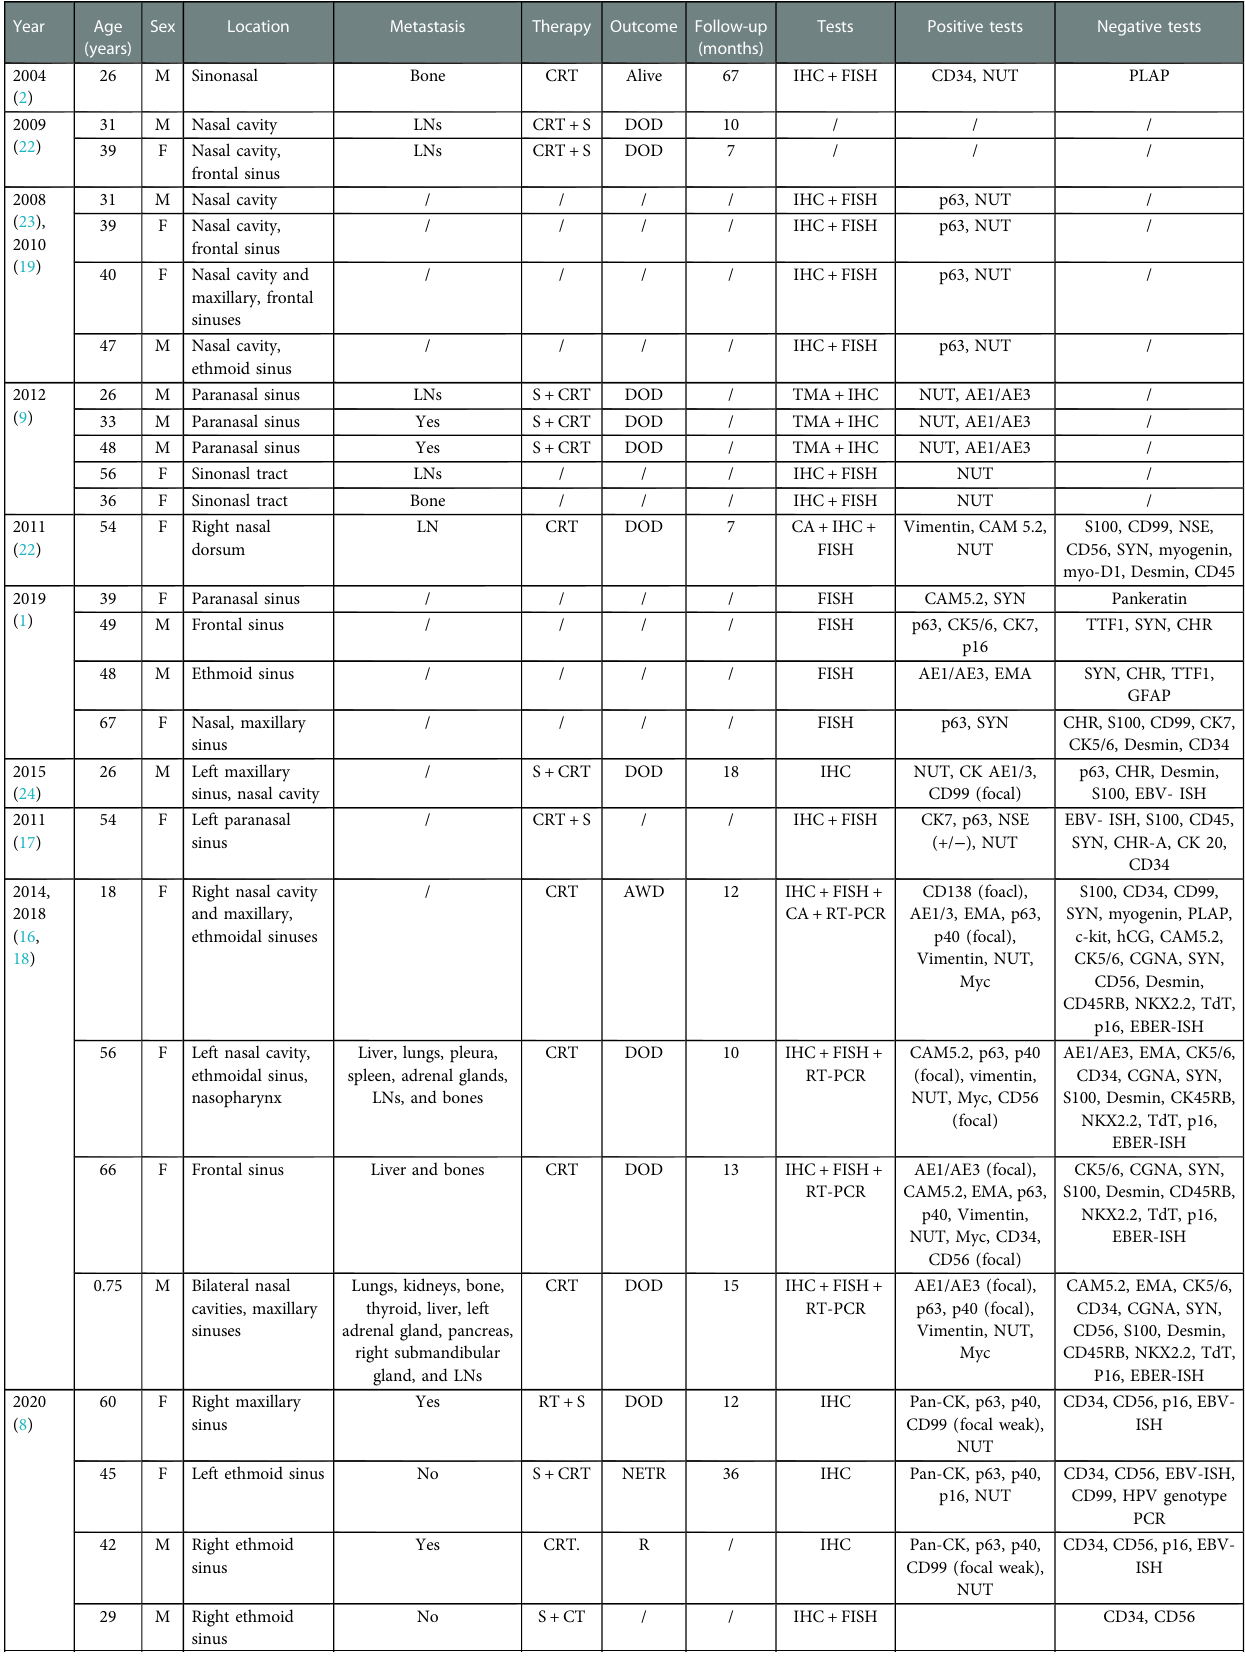
TABLE 3 Clinical and pathological features of sinonasal NUT carcinoma reported in the